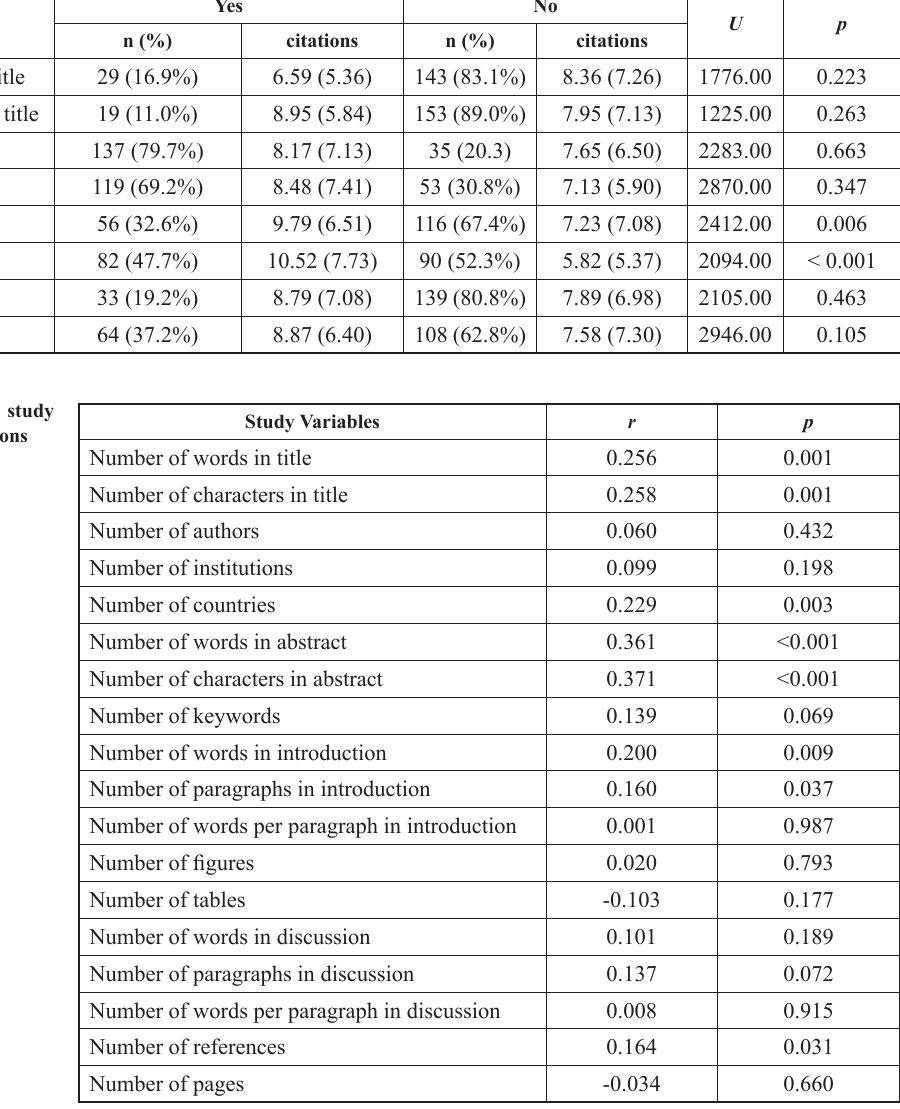
Table 4. Categorical variables and their citations according to selected journals